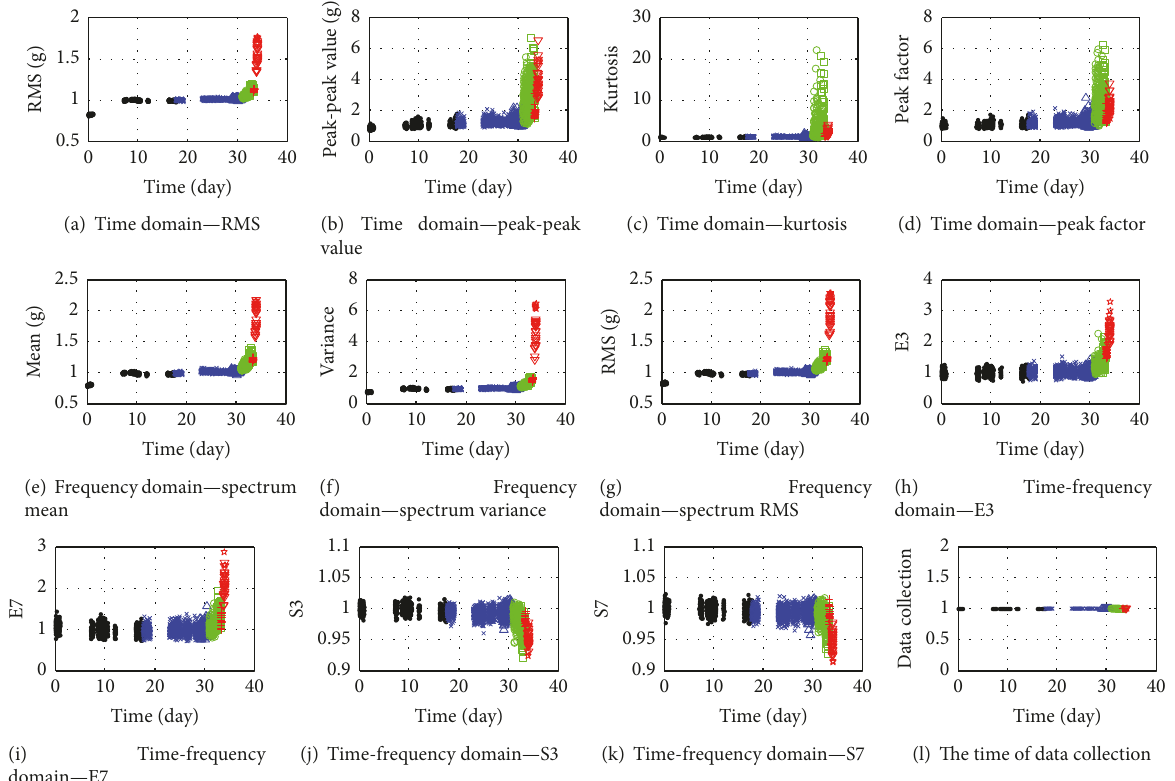
Figure 6: High test lifetime relative feature data (individual degradation stages).